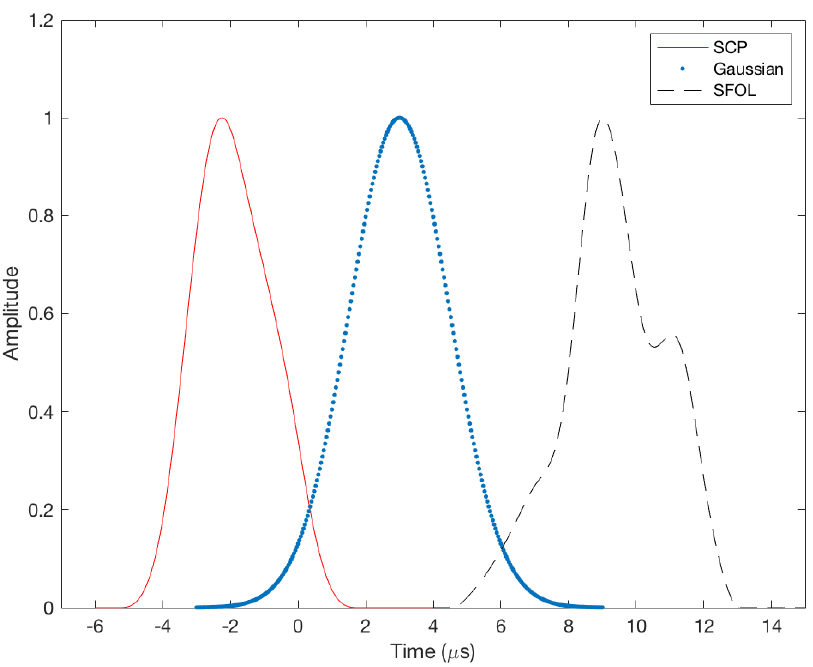
Figure 1. Comparison of Gaussian, Smoothed Concave Polygon, and Stretched-Front-Leg pulses.